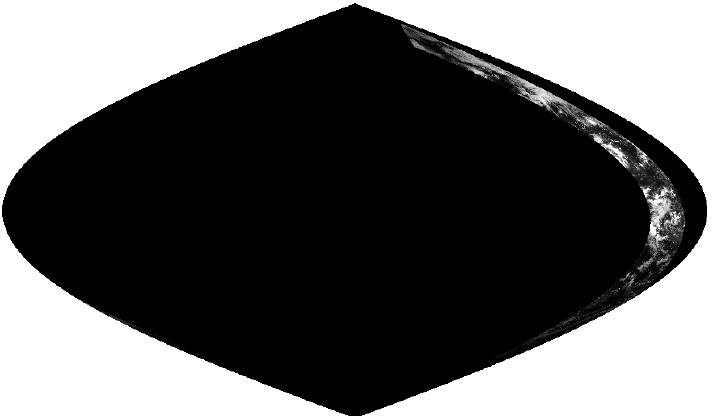
6 of 14 Figure 3. SE-net channel attention network model. FC replies to a fully connected layer. SE-net is a self-attention mechanism. It weights each channel with information from the channel itself, reducing the dependence on external data. It gives the model more free- dom and allows it to decide which channel is more valuable from the perspective of